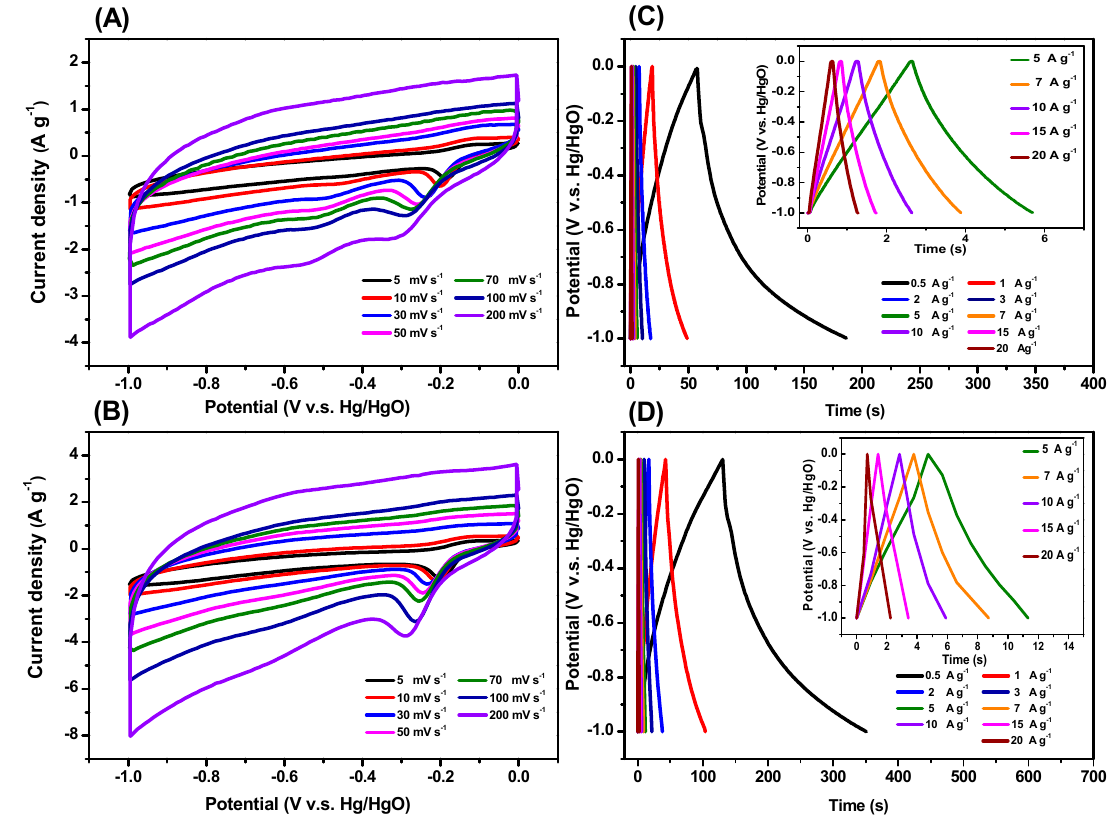
Figure 10. ( A , B ) CV and ( C , D ) GCD profiles, recorded in 1 M KOH, of the ( A , C ) TPE-HPP and ( B , D ) DPT-HPP.